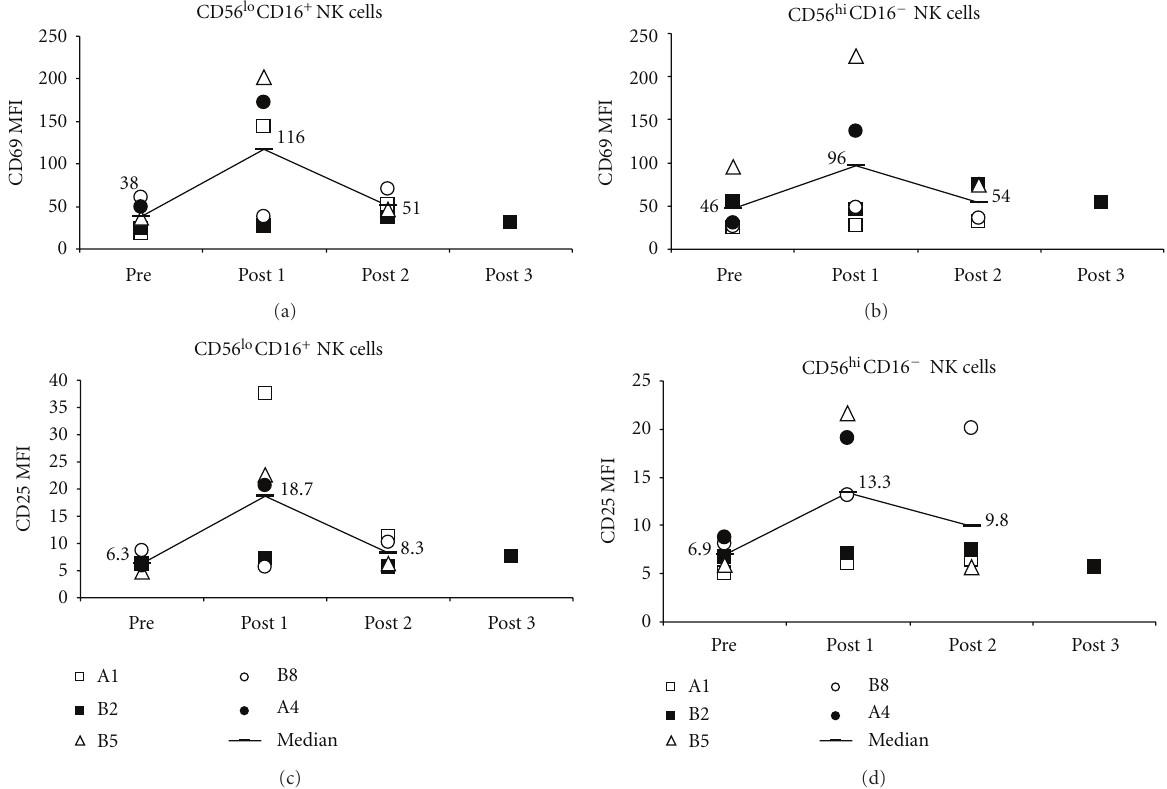
Figure 1: CD69 and CD25 expression on CD56 lo CD16 + and CD56 hi CD16 − NK cells. Phenotyping of NK cells from patients who received the AFP pep/DC vaccine, showing longitudinal changes. “Pre” denotes PBMC from time point 0. DC vaccines were delivered (after blood draws) on days 0, 14, and 28. “Post” denotes PBMC from postvaccine administration at time points available in the remaining batched PBMC. Patient A1 tested at days 35 and 56 (7 days and 28 days after the third vaccine); pt B2 at d28, 56, and 112; pt B5 at d14 and 28; pt B8 and d14 and 112, pt A4 at d14. CD69 and CD25 markers (by MFI) are shown for both NK cell subsets. Percent positivity is shown in Supplementary Figure 2. One-tail t -test P values are: CD56 lo CD16 + CD69 MFI: pre to post 1: 0.05; pre to post 2: 0.03; post 1 to post 2: 0.16; all other values higher and not significant (n.s.). CD56 hi CD16 − CD69 MFI: pre to post 1: 0.07, all other values higher and